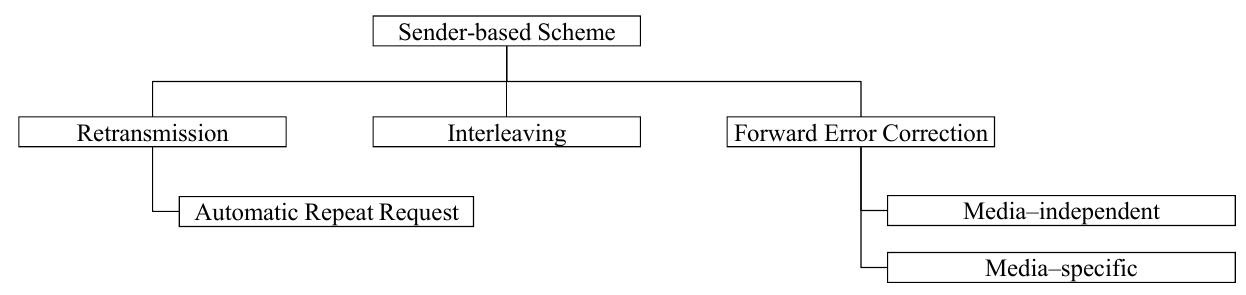
Figure 2. Classification of sender-based error protection